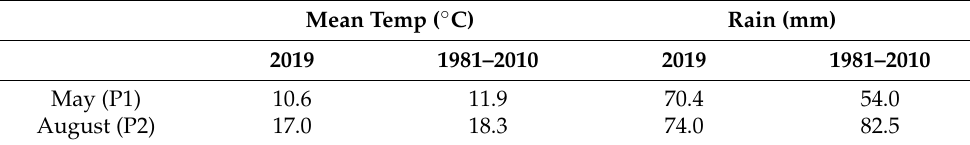
Table 1. Mean temperature and cumulative precipitation during the experimental months (May and August) in the experimental year 2019 and the 30-year average.